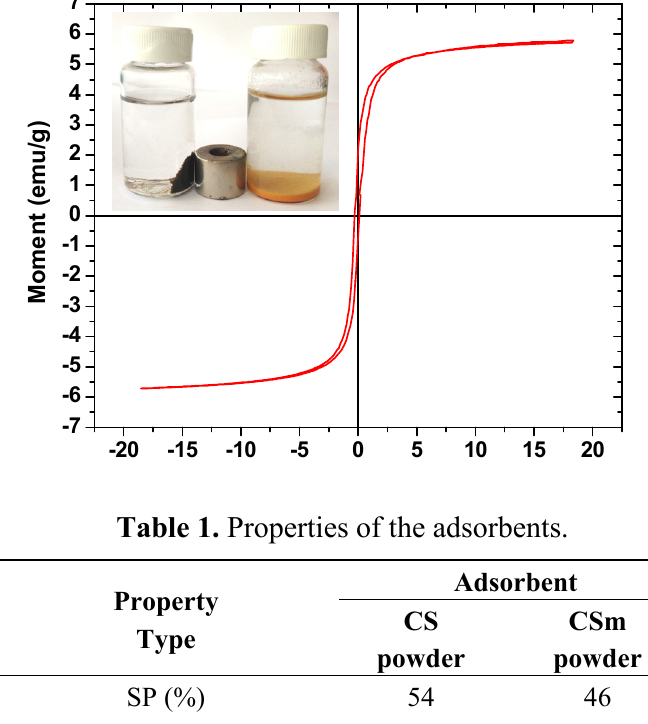
Figure 4. VSM plot of CSm (Inset: photo of CS and CSm after Hg(II) adsorption).